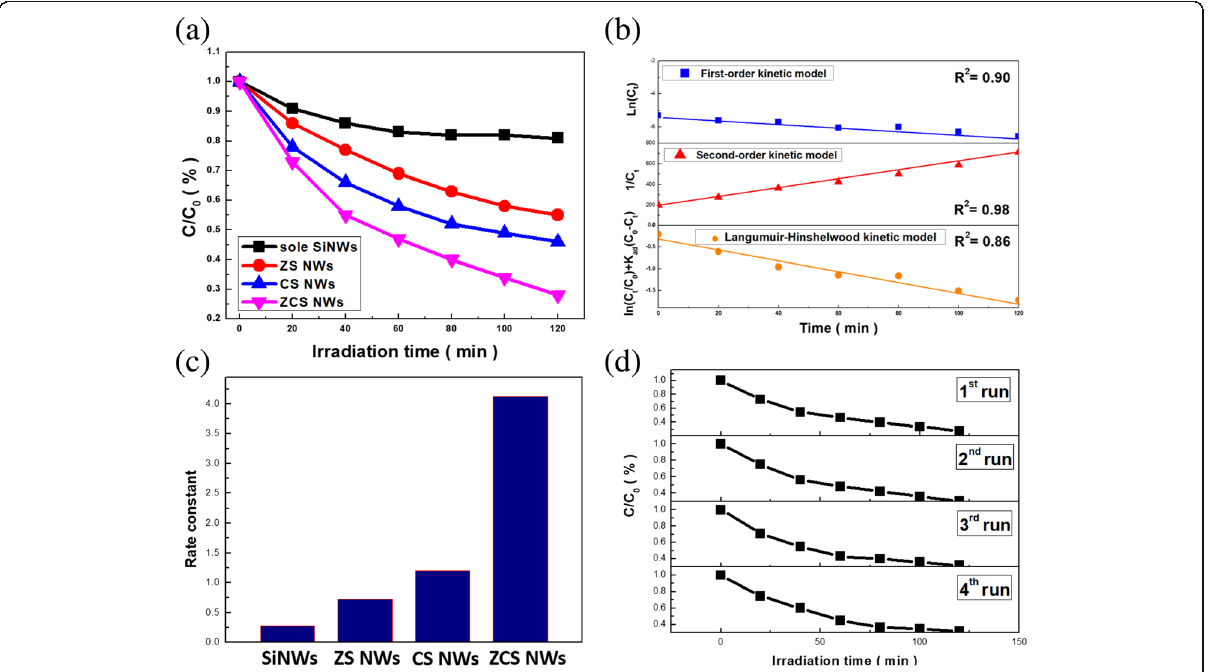
Fig. 4 a Photocatalytic tests of various photocatalysts. b Kinetic modeling of the photodegradation in the presence of ZCS nanowires. c Evaluated rate constants of four various photocatalysts. d Repeated photodegradation tests of ZCS nanowires (1-4